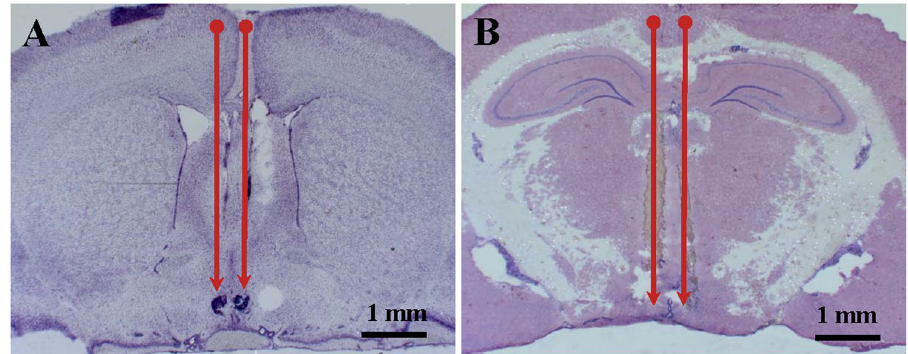
Figure 1. Photomicrograph of the cannulae targeted sites in the hypothalamic anteroventral periventricular (AVPV) and the arcuate (ARC). Photomicrograph of cresyl-violet stained coronal section showing representative examples of bilateral cannula placement in the AVPV ( A ) and ARC ( B ) respectively. Magnification, × 1.25. The arrows indicate the site of cannula